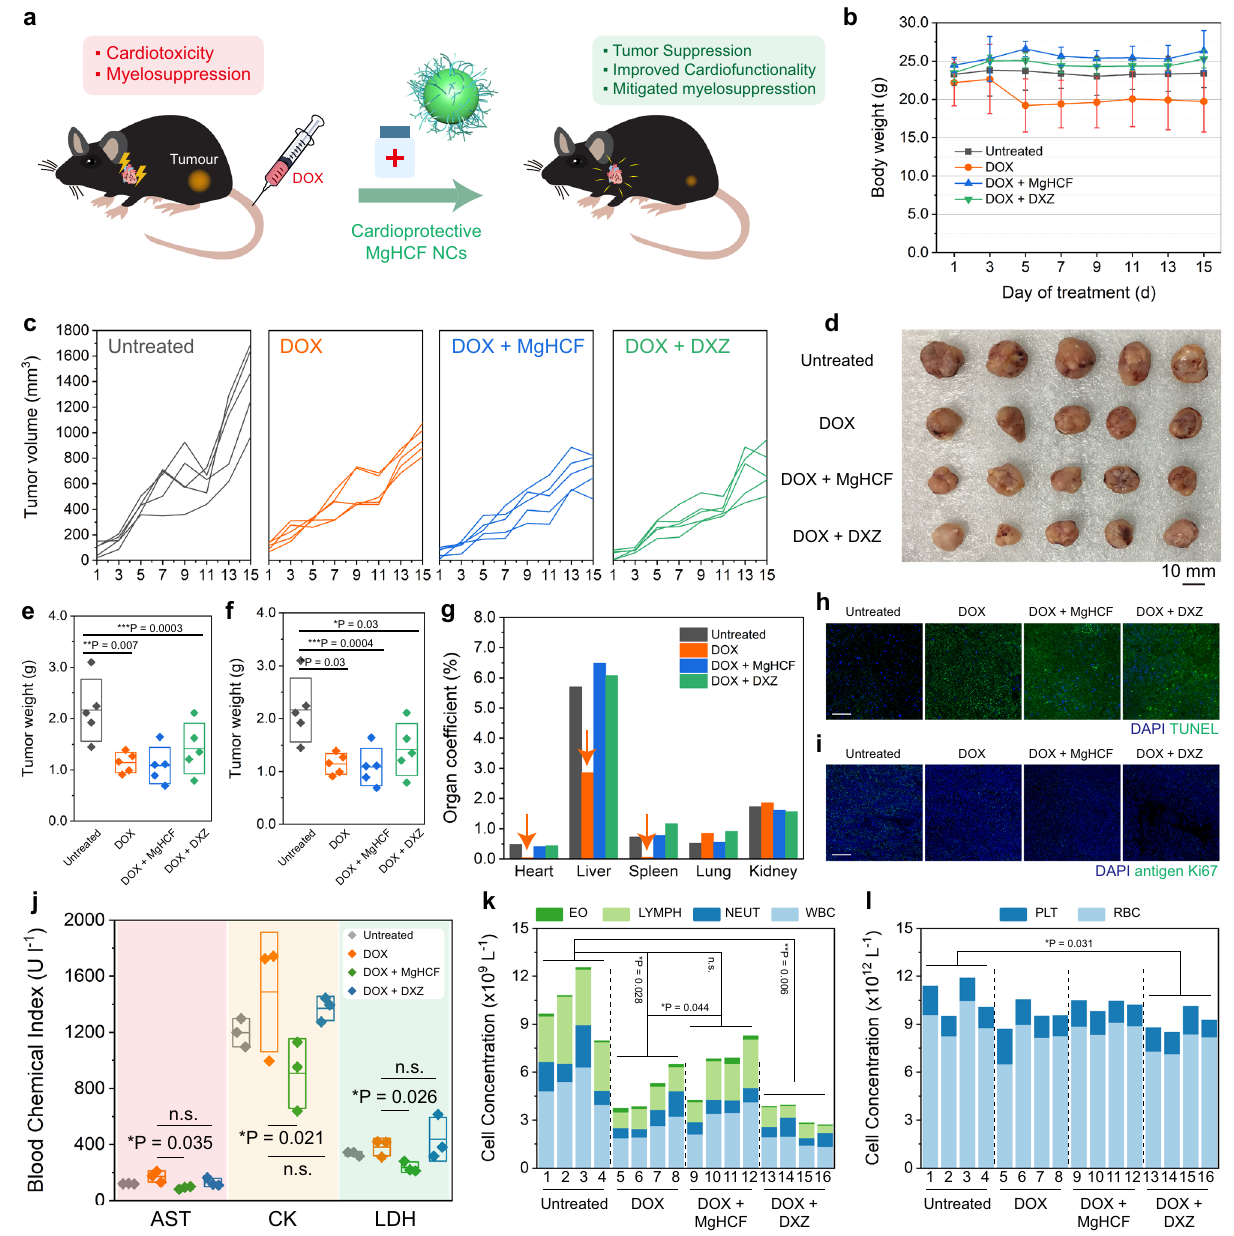
Fig. 8 | In vivo anti-tumour performances and side effect evaluation. a Schematic illustration of the in vivo anti-tumour experiment. b Body weight pro fi les of mice in different groups during the in vivo anti-tumour investigation. n =5. Data are presented as mean±s.d. c Xenograft development curves for each mouse from different groups in the therapeutic evaluation period. d Digital pho- tograph of the dissected tumour xenografts from each mouse of different groups. e and f Tumour weights ( e ) and tumour volumes ( f ) of the xenografts dissected from each mouse of different groups. n =5. Data are presented as they are and mean±s.d. Statistical signi fi cance (to the control group) is assessed by Student t ’ s two-tailed test. * P <0.05, ** P <0.01 and *** P <0.001. g Organ coef fi cient of mice from different groups, calculated as the ratio of the organ weight to body weight.